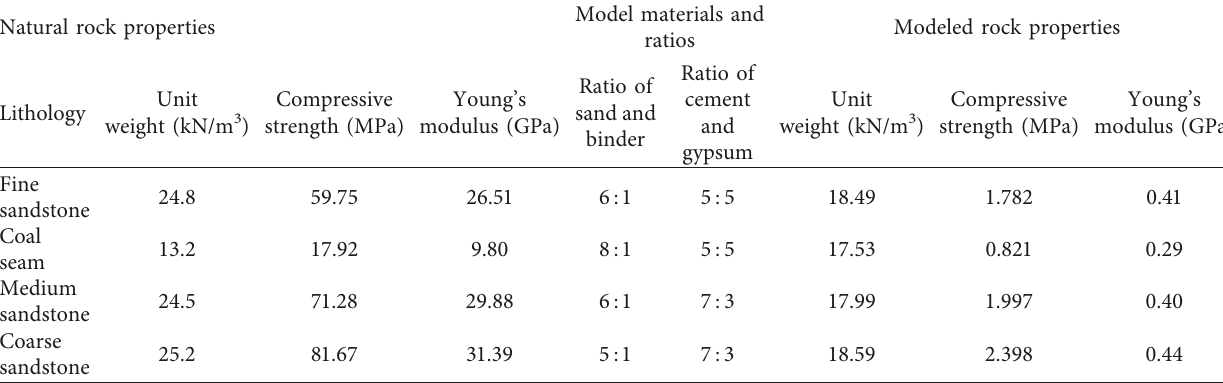
Table 2: Mechanical and material properties of